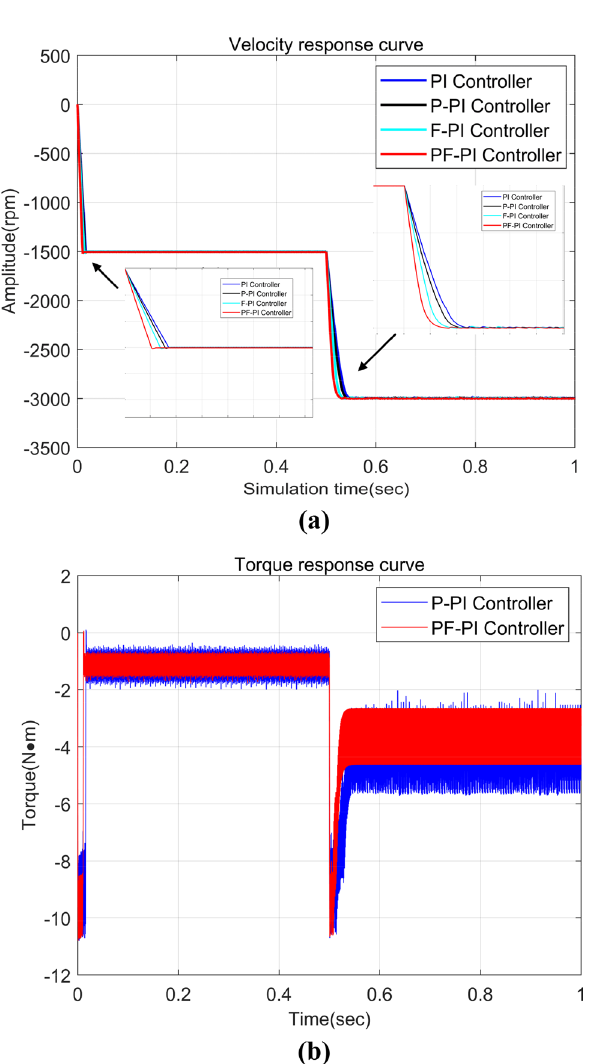
Fig. 15 Reverse operation curves of variable speed sudden addi- tion disturbance load start a speed and b torque